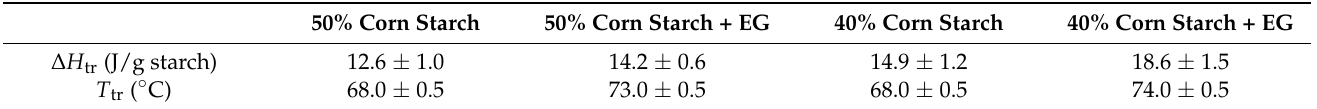
Figure 2. DSC thermograms of starch suspensions in water and 30% ethylene glycol (EG). ( a ) 50% ( w / w ) corn starch solution in water (blackline) and in 30% EG solution (red line) ( b ) 40% ( w / w ) corn starch suspensions in water (black line) and in 30% EG solution (red line). The lines represent averages of three independent experiments ( n = 3) and the line thickness corresponds to SD. Table 3. Comparison of thermodynamic parameters associated with thermally induced transition of different amounts of corn starch in water and 30% ethylene